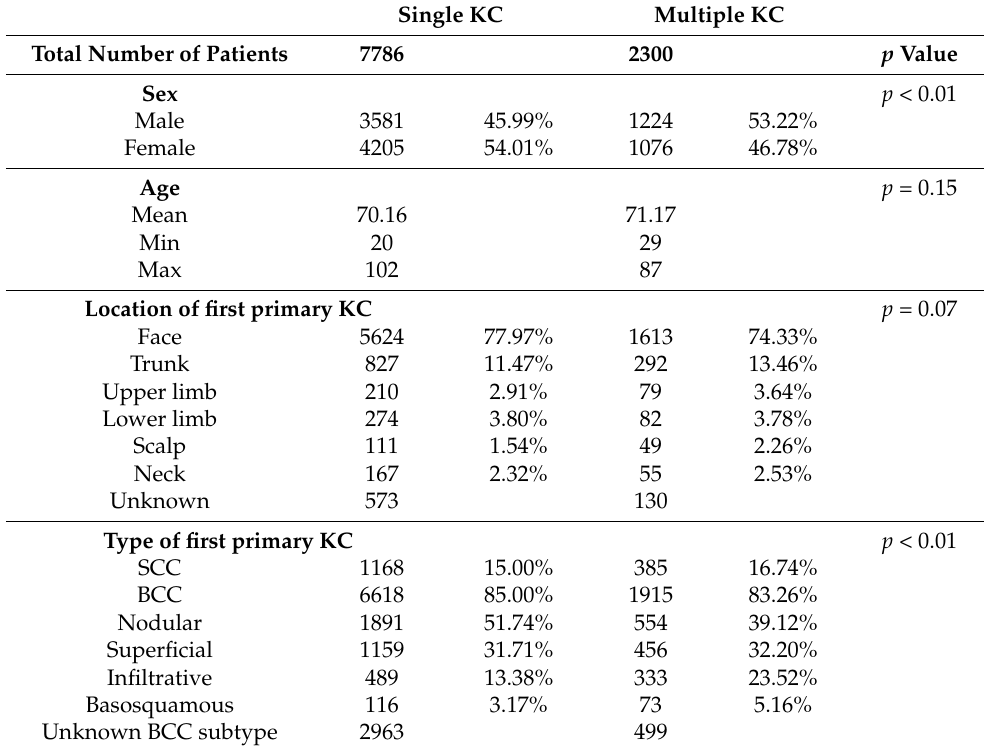
Table 1. Clinical variables of patients with single and multiple KC.